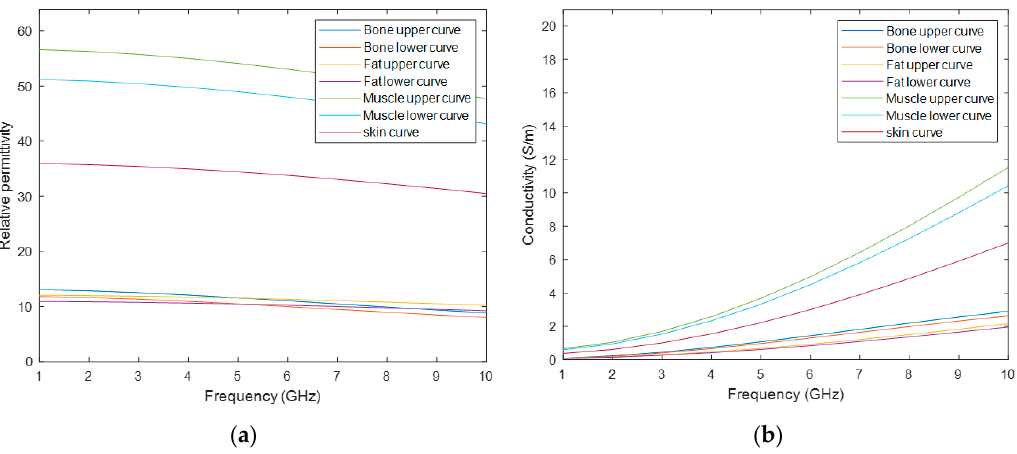
Figure 2. Dielectric properties curves considered to assign the dielectric properties to the tissues in the phantoms. The curves were obtained by using the 4-pole Cole–Cole formulation with the parameters given in [30]. ( a ) depicts the graph of the relative permittivity curves for bone, fat, muscle and skin tissues. ( b ) depicts the graph of the conductivity curves for the considered biological tissues.